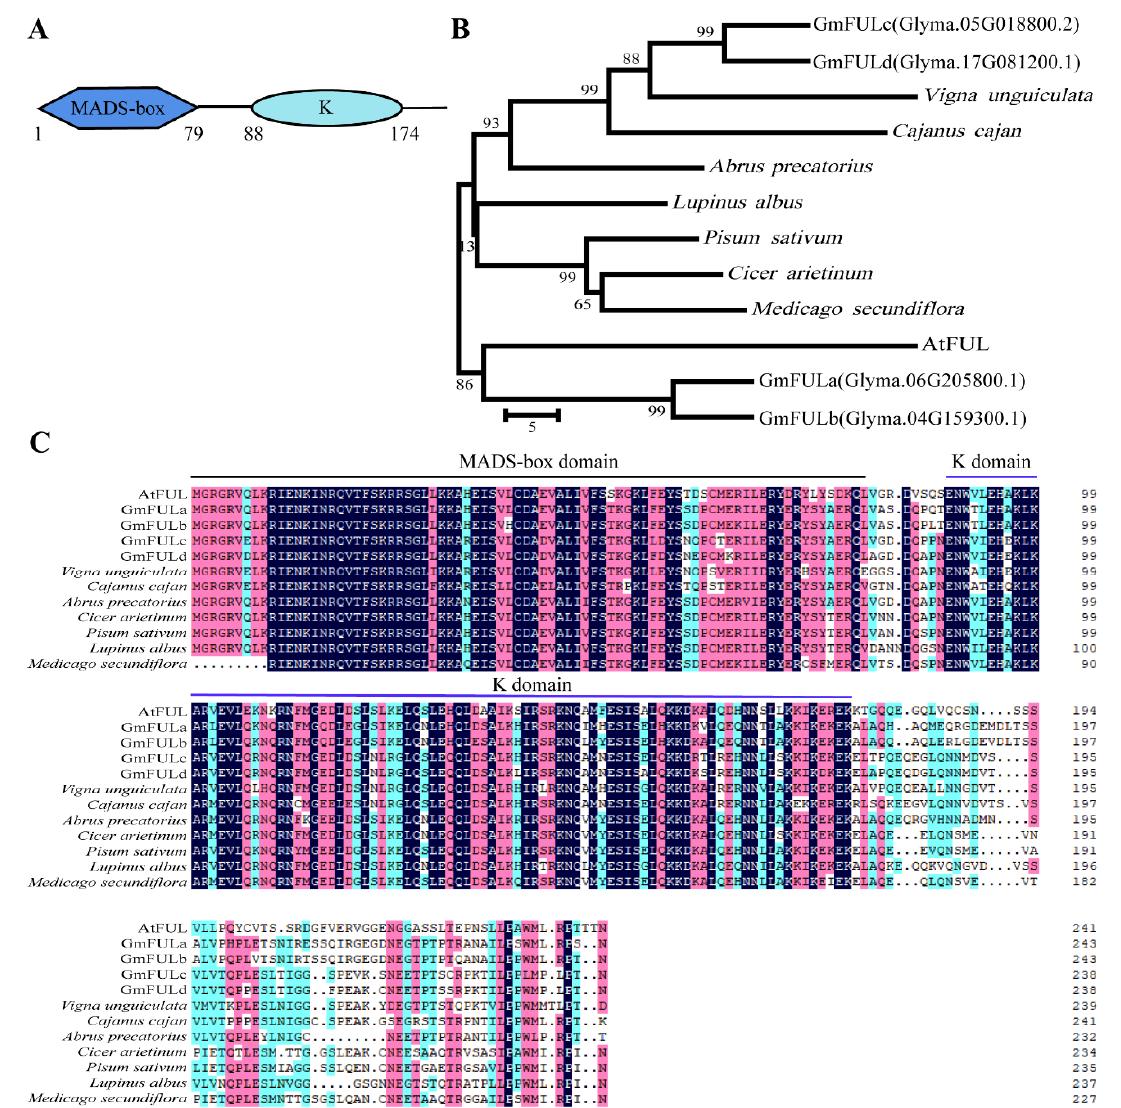
Figure 1. Sequence and phylogenetic tree analysis and subcellular localization of GmFULc. ( A ) Predicted domains of GmFULc. ( B ) Phylogenetic relationships of GmFULc and some FUL proteins from other species. Accession numbers are listed in Supplementary Table S1. Phylogenetic tree containing four soybean proteins with the complete MADS-box domain and eight FUL proteins from Arabidopsis thaliana , Vigna unguiculata , Cajanus cajan , Abrus precatorius , Cicer arietinum , Pisum sativum , Lupinus albus and Medicago secundiflora . Phylogenetic tree was constructed using the neighbor joining method with 1000 bootstrap replicates by MEGA 6.0. ( C ) Sequence alignment of GmFULc and other FUL proteins from other species. The MADS and K-domain were indicated by the line on the top. The black line and the blue line mark the MADS-box domain (1–79 aa) and the K-domain (88–174 aa), respectively. Light blue, homology ≥ 50%; pink, homology ≥ 75%; blue, homology 100%.